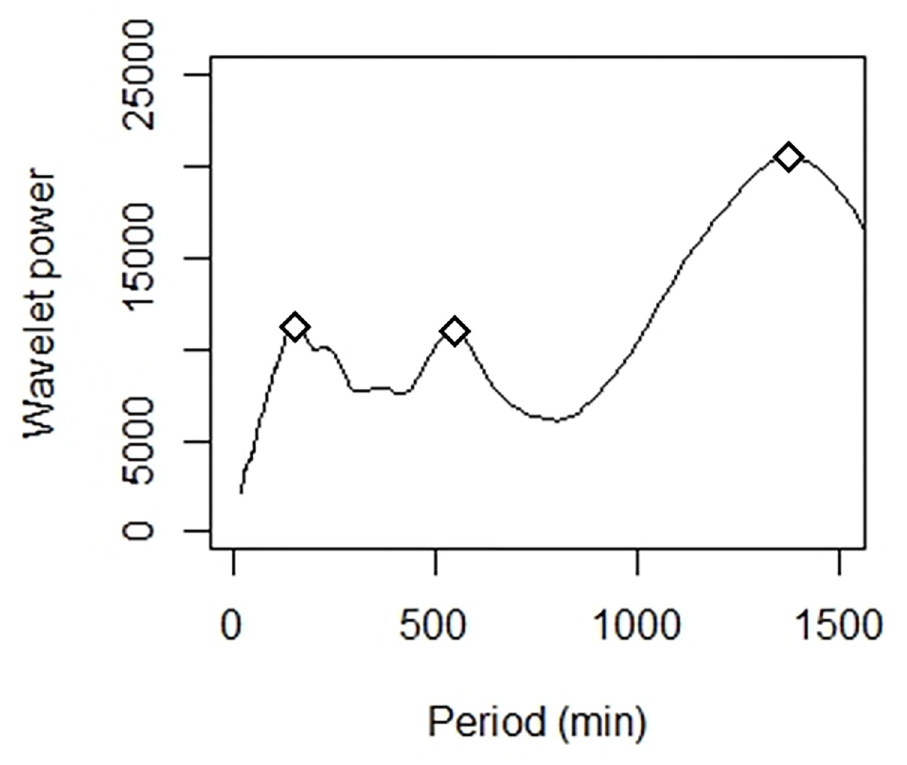
Fig 8. Distribution of the wavelet power of each tested period for colony 7 during the starvation phase. The three most prominent periods are highlighted with the black squares. They correspond to periodicities of 2h23 (left), 8h59 (middle) and the most dominant period of 22h48